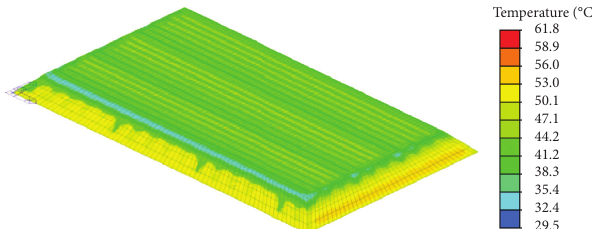
Figure 10: Distribution of the maximum temperature field of the tower (unit: °